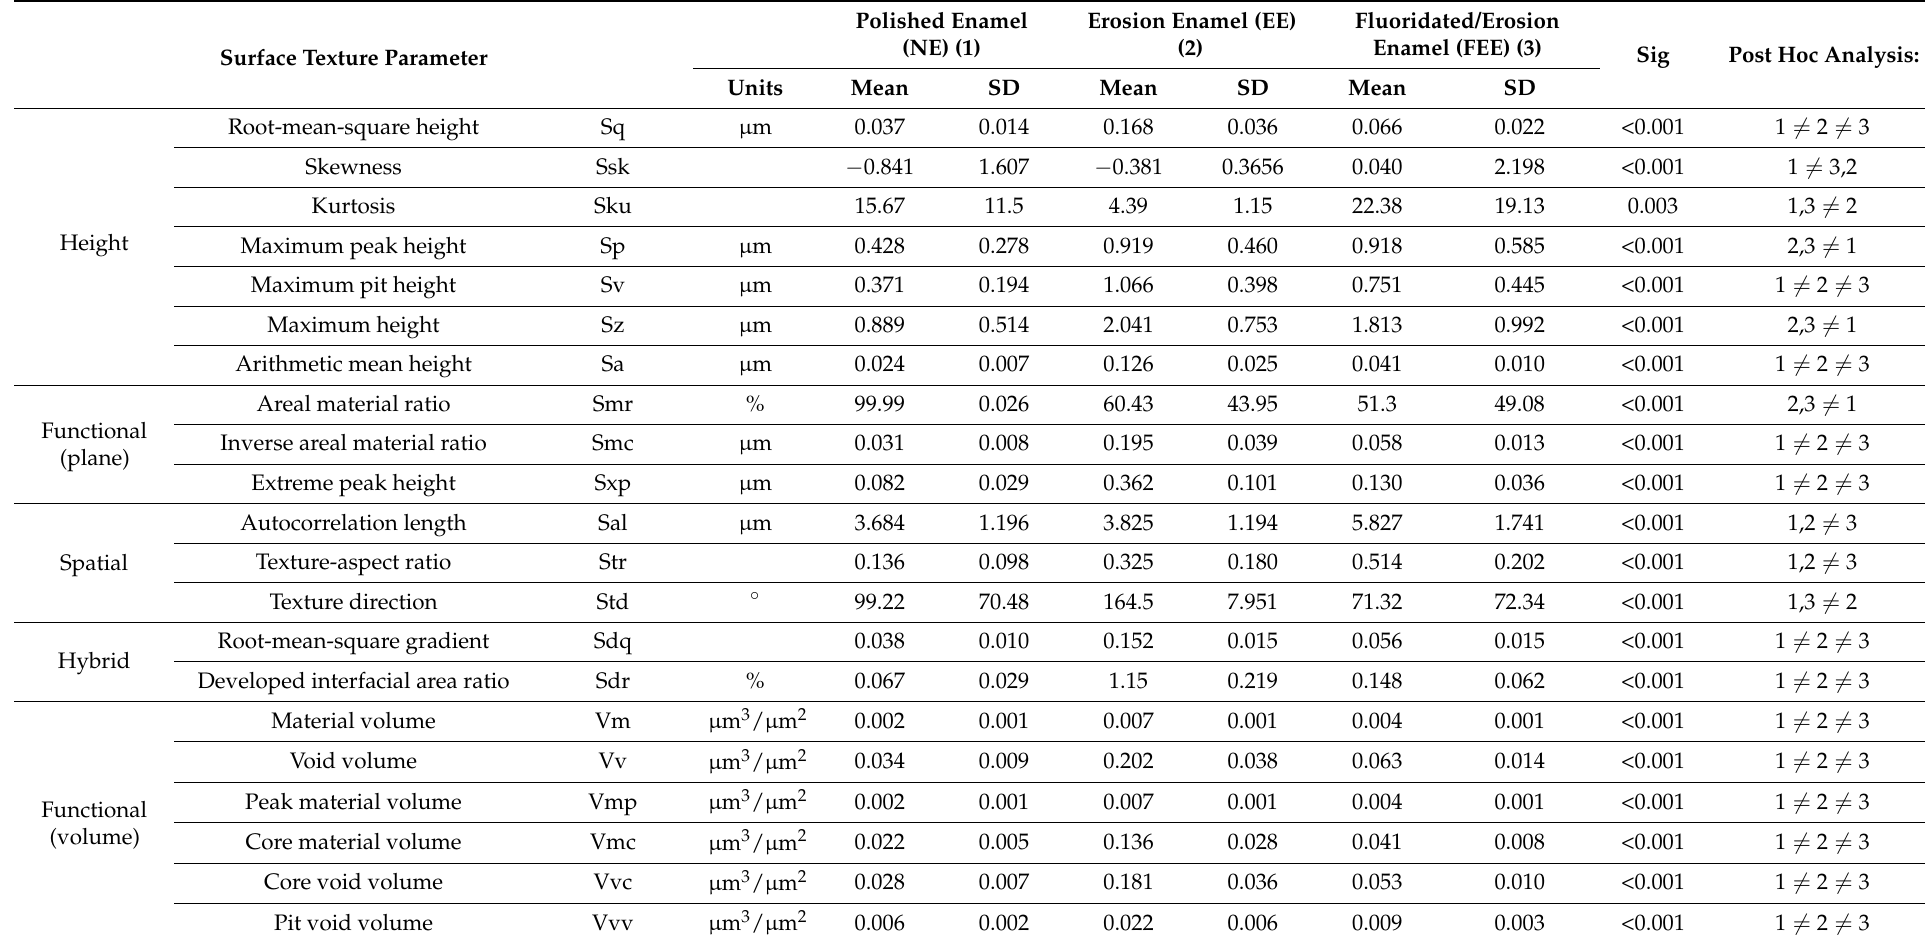
Table 1. Descriptive statistics of surface texture parameters (ISO 25178-2) are given for the 50 examined teeth (Mean, Standard deviation = SD), divided into the three experimental groups. p -value for comparisons resulting from the ANOVA are shown, and post hoc (Tukey) analysis uncover specific significant differences between the three